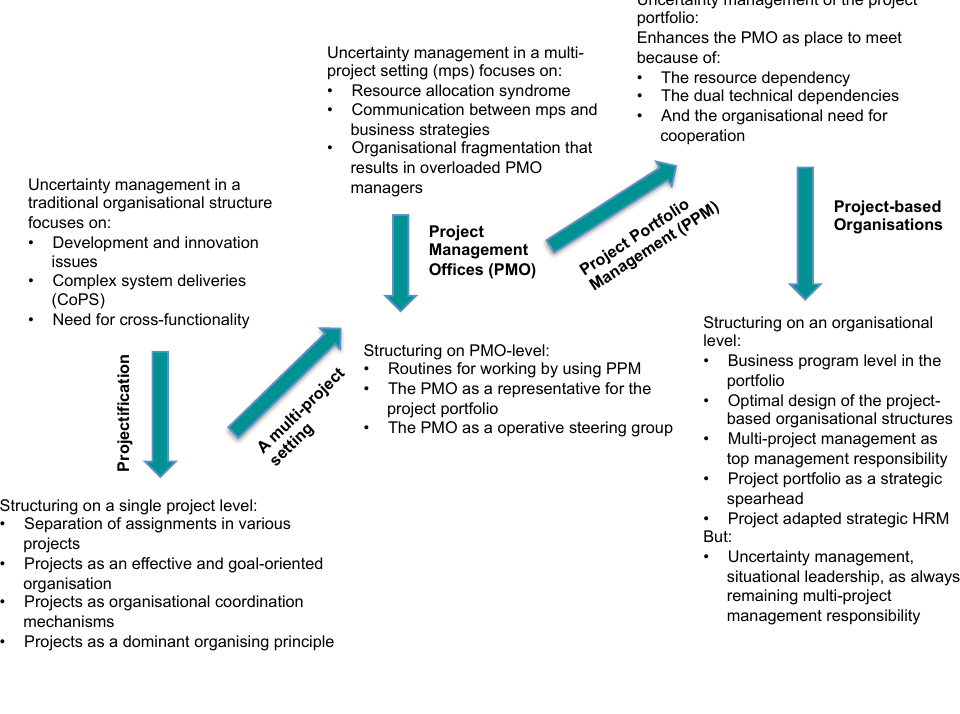
A maturation model of PBO oscillating between structuring activities and uncertainty